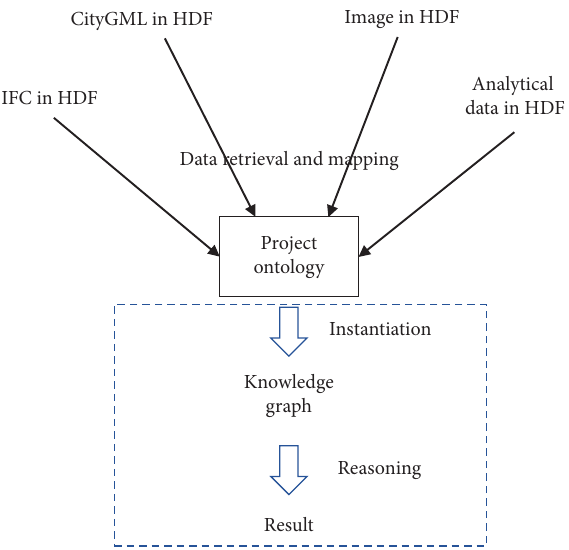
Figure 17: Technique route of data aggregation phase.